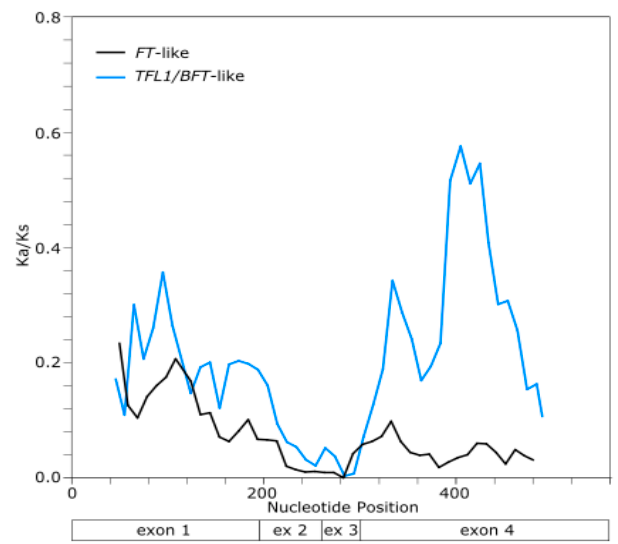
Figure 6. Average pairwise ratio of nonsynonymous (Ka) to synonymous substitutions (Ks) (sliding window, window size 50, step 10) of Kalanchoë PEBP genes. TFL1 / BFT genes show an excess of nonsynonymous substitutions in exon 4.